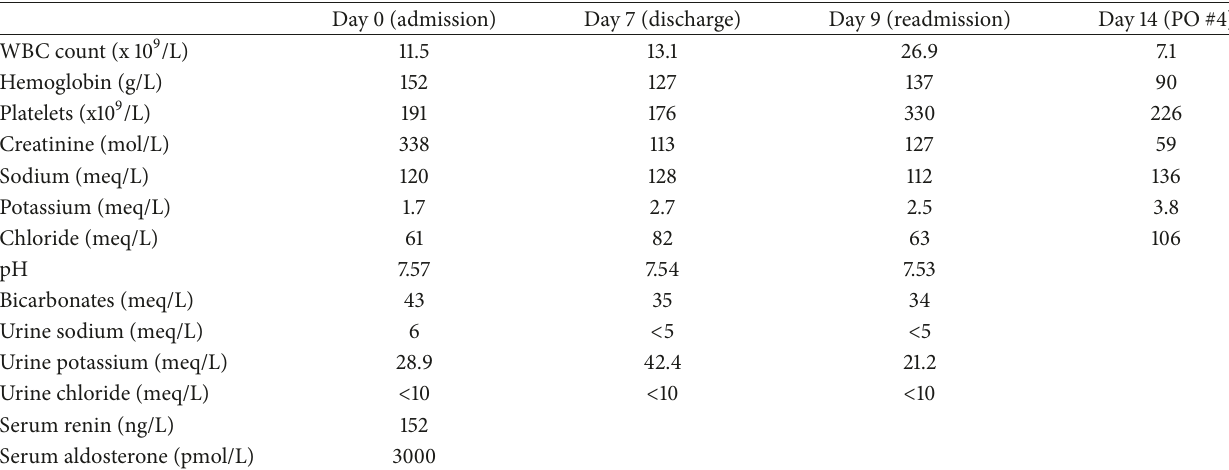
Table 1: Laboratory values from first admission to postoperative day